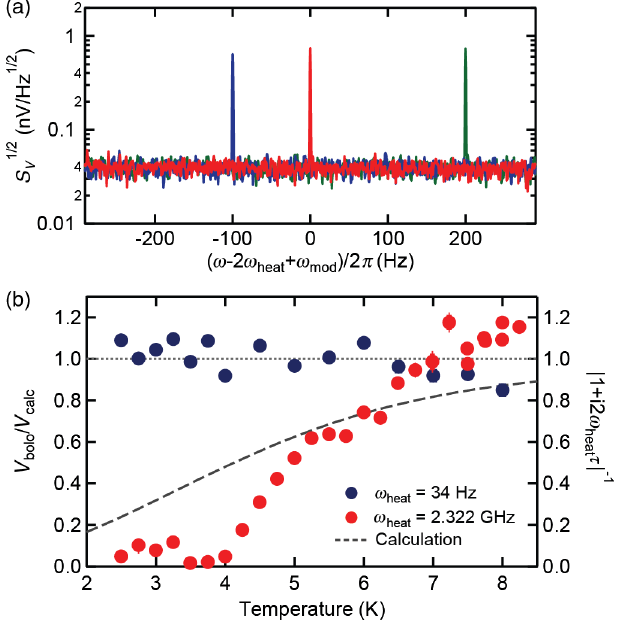
FIG. 3. Panel(a)showsthepowerspectraldensity,attheinputof the HEMT, due to bolometric mixing. The central, 600-pV red = 2 (cid:2) ¼ 1 : 161 GHz , which tone is due to a heating signal at ! heat produces a temperature response at 2.322 GHz, which is then ¼ ! þ 2 (cid:2) (cid:3) 1 kHz using a small modu- mixed down to ! bolo heat ¼ ! (cid:2) 2 (cid:2) (cid:3) 1 kHz . The blue spike, shifted lation tone at ! mod heat down by 100 Hz, is the result of increasing the modulation tone by 100 Hz. Thegreen spike, shifted up by 200 Hz, is due to increasing the heating tone by 100 Hz, validating the expected relationship: ! ¼ 2 ! (cid:2) ! . (b) A plot of the measured bolometric bolo heat mod mixing tone normalized by our expected signal under the assump- tion that the graphene thermal time constant (cid:4) ¼ 0 . The red points = 2 (cid:2) ¼ 1 : 161 GHz , the are measured with a heating tone of ! heat = 2 (cid:2) ¼ 17 : 6 Hz , and both are blue points are measured with ! heat measured with a modulation tone of 1.161 GHz–1 kHz. The dashed line shows the expected roll-off of the bolometric signal = 2 (cid:2) ¼ 2 : 32 GHz and (cid:4) ¼ C =G when 2 ! e heat ep